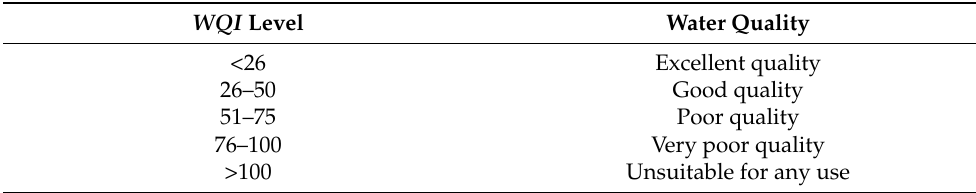
Table 3. Water quality classification for